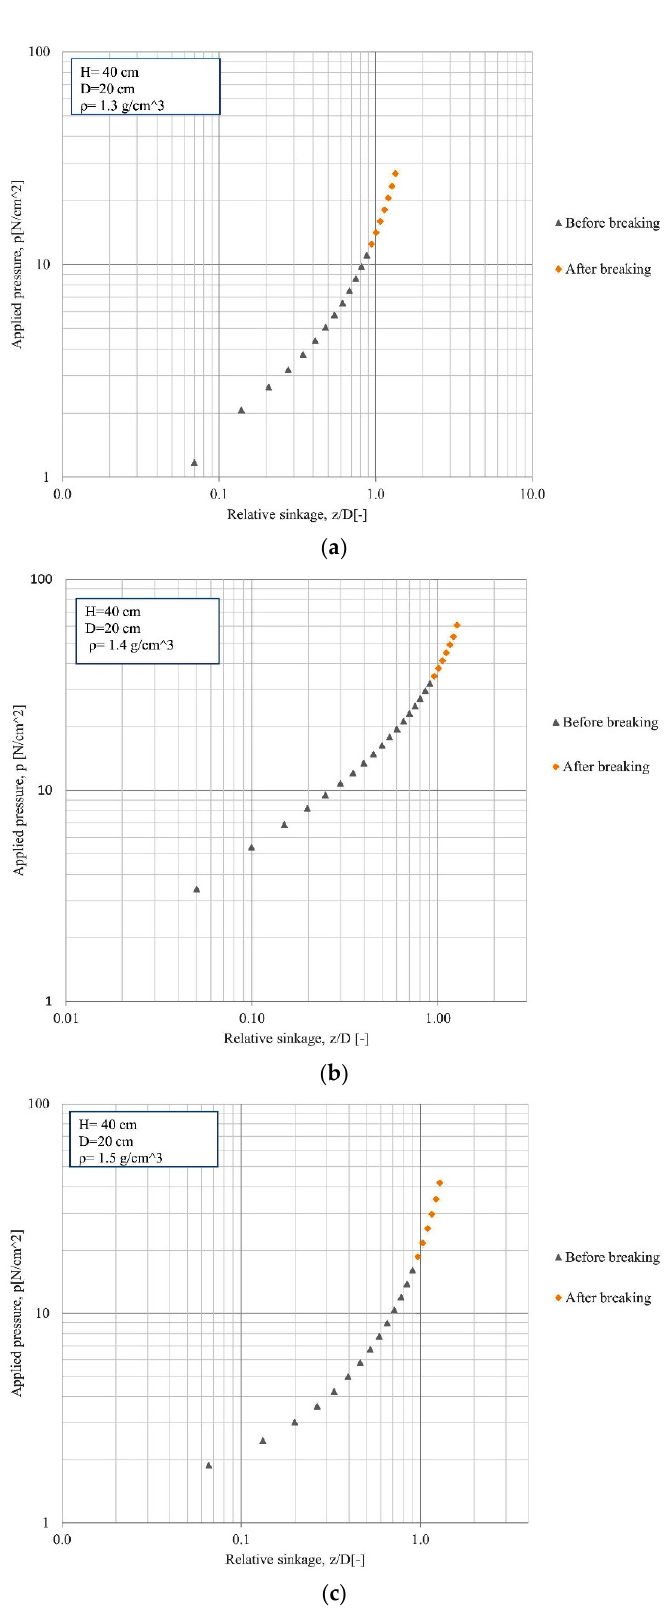
Figure 5. Pressure–sinkage curves for a soil thickness level of 40 cm at bulk densities of ( a ) 1.3 g/cm 3 , ( b ) 1.4 g/cm 3 , and ( c ) 1.5 g/cm 3